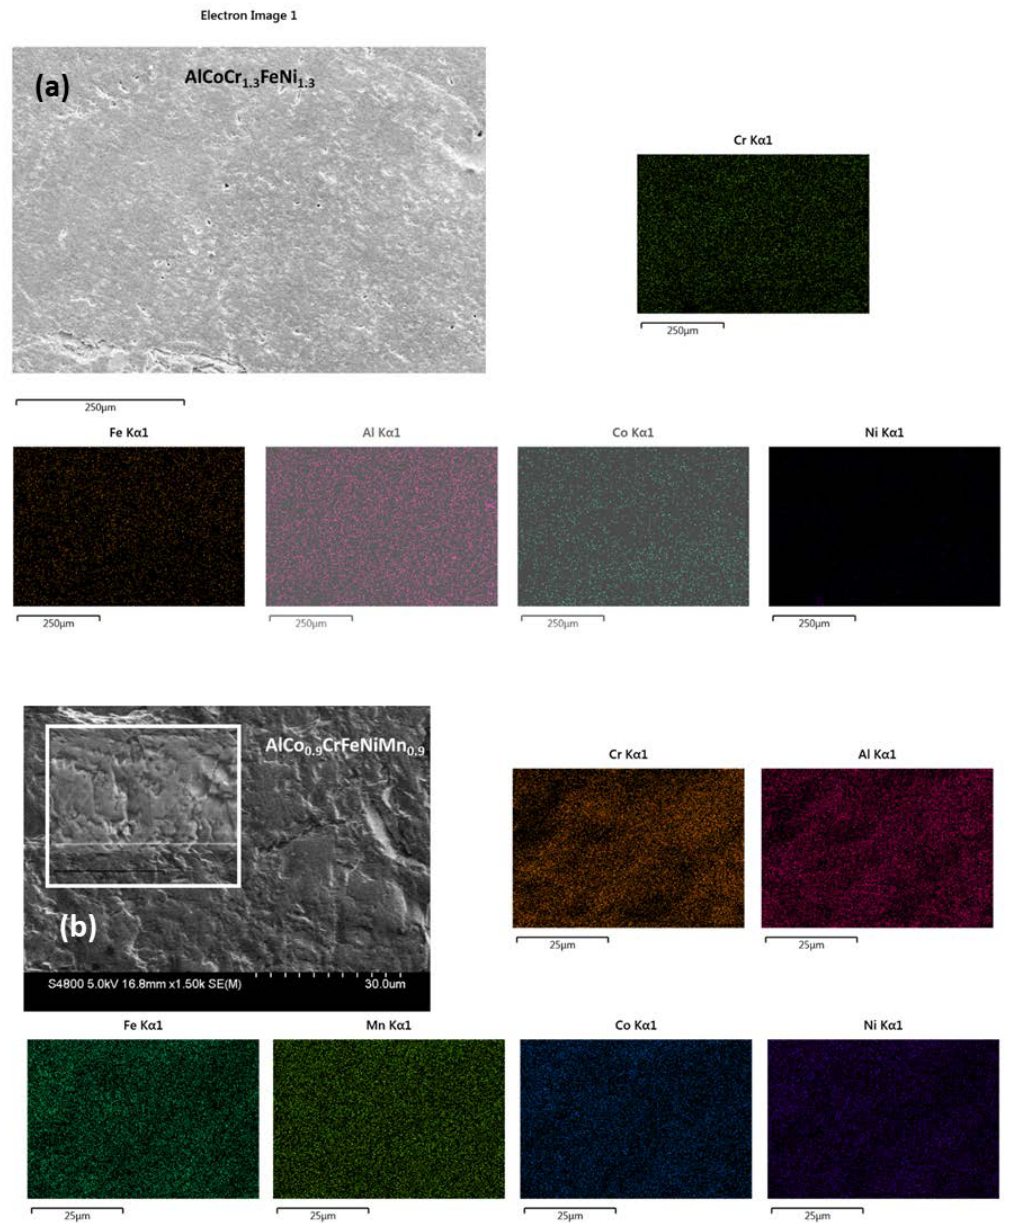
Figure A11. ( a ) SEM image and EDS elemental map of additive manufactured HEA sample (AlCoCr 1.3 FeNi 1.3 ). ( b ). SEM image and EDS elemental map of additive manufactured HEA sample (AlCo 0.9 CrFeMn 0.9 Ni).